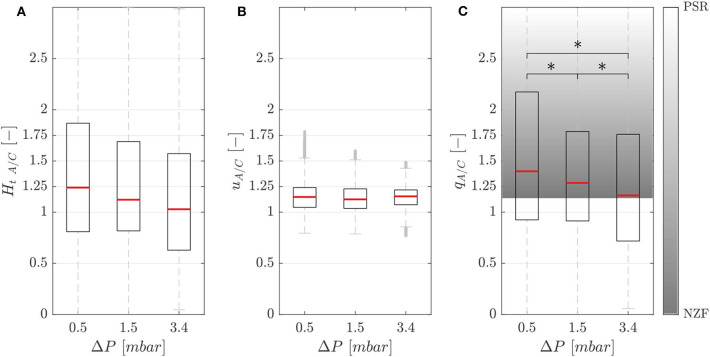
Phase separation results. Hematocrit (A), velocity (B), and RBC flux (C) ratios between the activated and control branch in function of perfusion pressure for the single-mesh network with membrane thickness t1 = 5 μm, pressure in the chamber p = 2.25 bar and feeding hematocrit Hf = 5% (*p-value < 0.05). The shaded area represents the range between the no-Zweifach-Fung (NZF) and perfectly-self-regulated (PSR) conditions. Boxes indicate the 25th and 75th percentiles; red lines: median values; gray + are outliers.